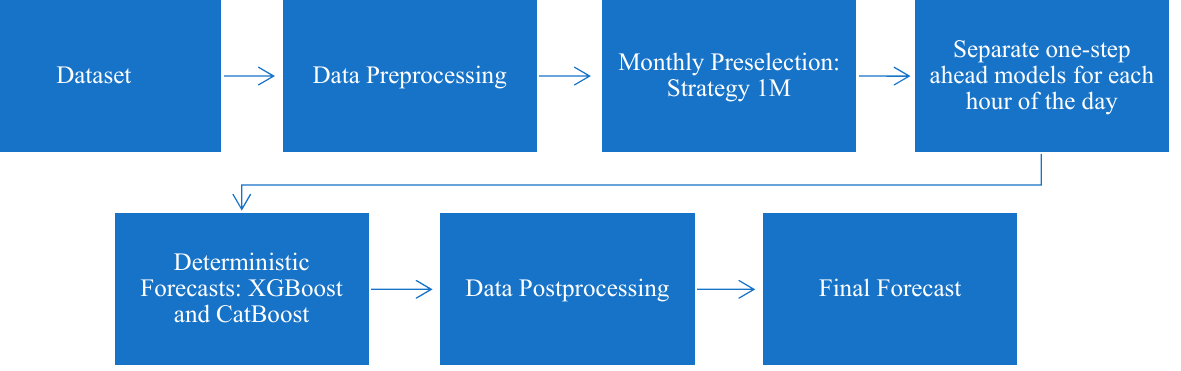
Figure 1. The proposed solar power forecasting methodology.